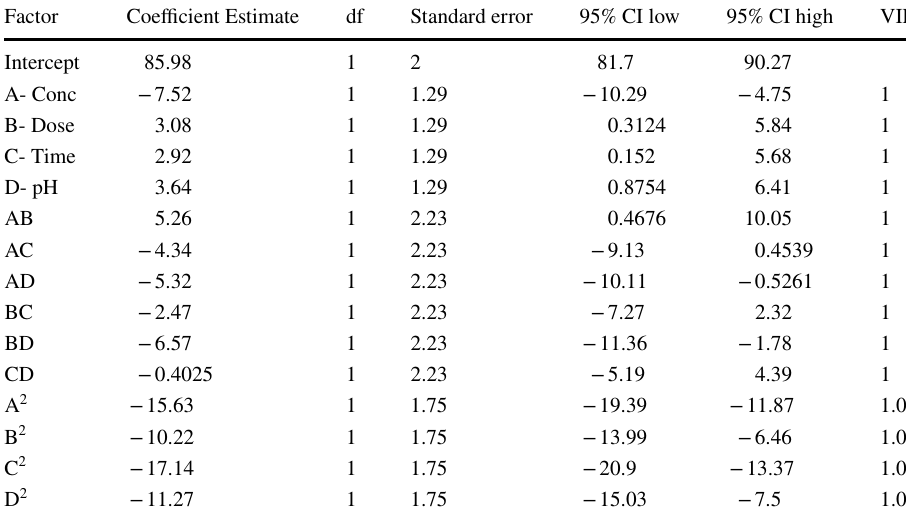
Table 5 Coefficients estimation for quadratic model of MNZ removal by S. platensis